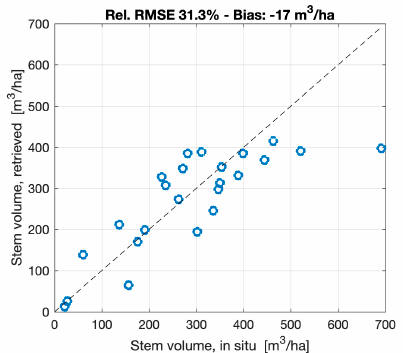
Figure 15. Scatter plots of measured and retrieved stem volume for 24 0.5-ha forest field inventory plots at Remningstorp. The retrieved stem volume was obtained with a combination of all estimates from SAR backscatter images acquired at X-, C-, and L-band.